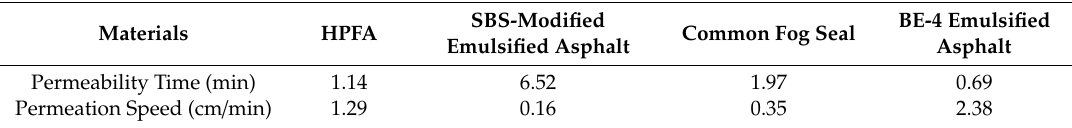
Table 6. Permeability of di ff erent fog seal.